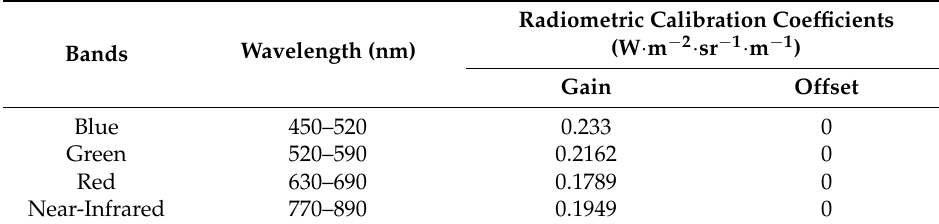
Table 1. Band information of the ZY-3 multispectral satellite